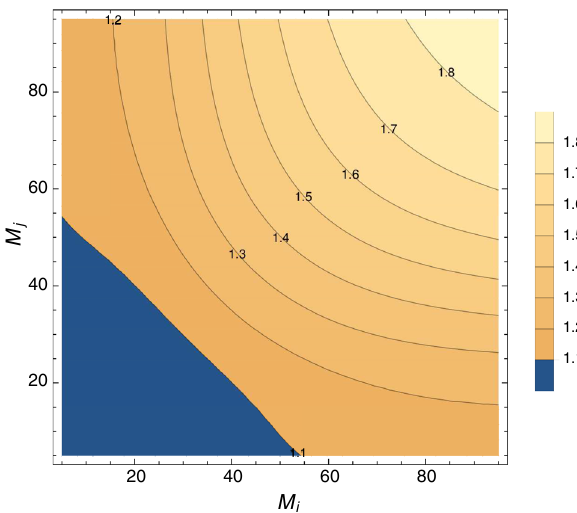
Fig. 8 Contouroftheratioofthetotalmergerratedensitytothesingle- merger one in the PBH mass plane in the case of f pbh = 0 . 01, m c = 15 M (cid:2) and σ = 0 . 5 R ( t , 30 M (cid:2) , 30 M (cid:2) ) = 8 . 55 × 10 − 7 Gpc − 3 year − 1 M − 2 1 0